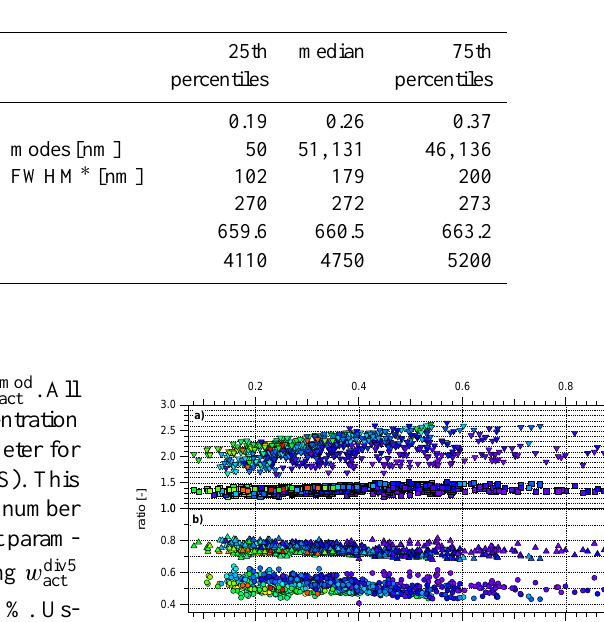
Table 2. Box model input parameters used for Fig. 3. The 25th, median and 75th percentile of the dry aerosol number size distribution were calculated binwise. The median and 75th percentile of the dry aerosol number size distribution resulted in a bimodal distribution and thus two modes are given.